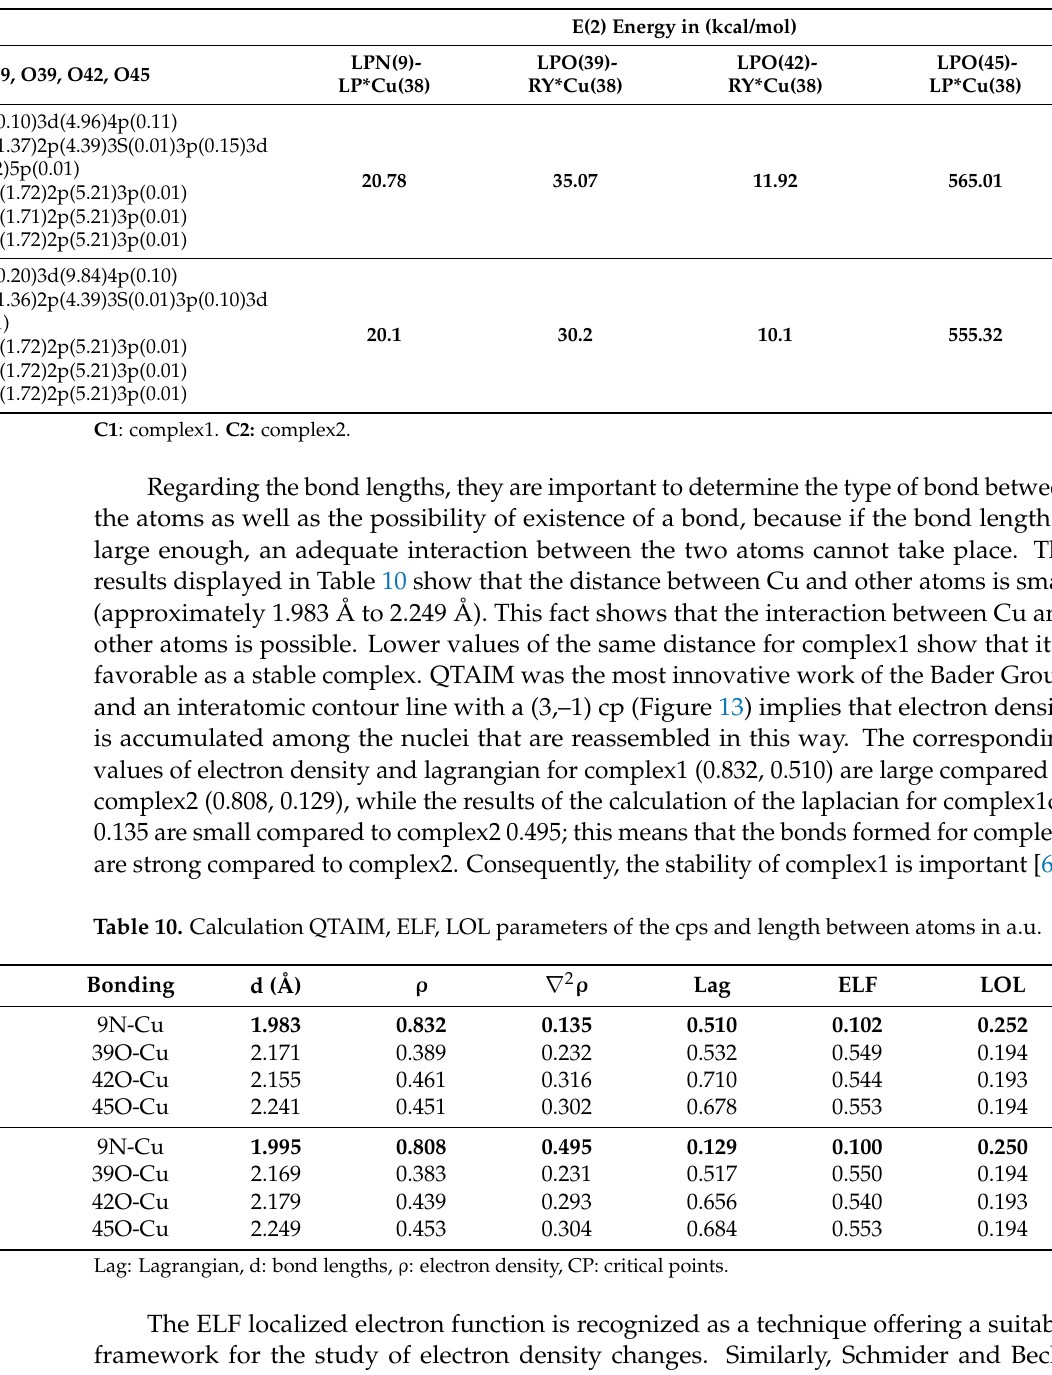
Table 9. NBO analysis calculations for complexes 1 and 2.